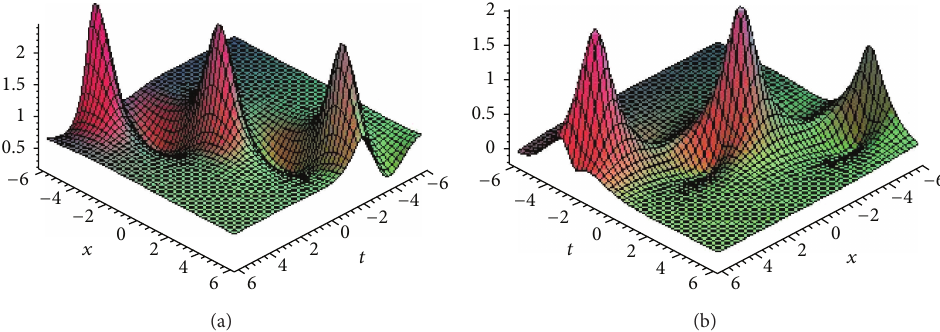
Figure 1: (a) Homoclinic breather wave of |𝑢 1 | in DSI. (b) Homoclinic breather wave of V 1 in DSI.